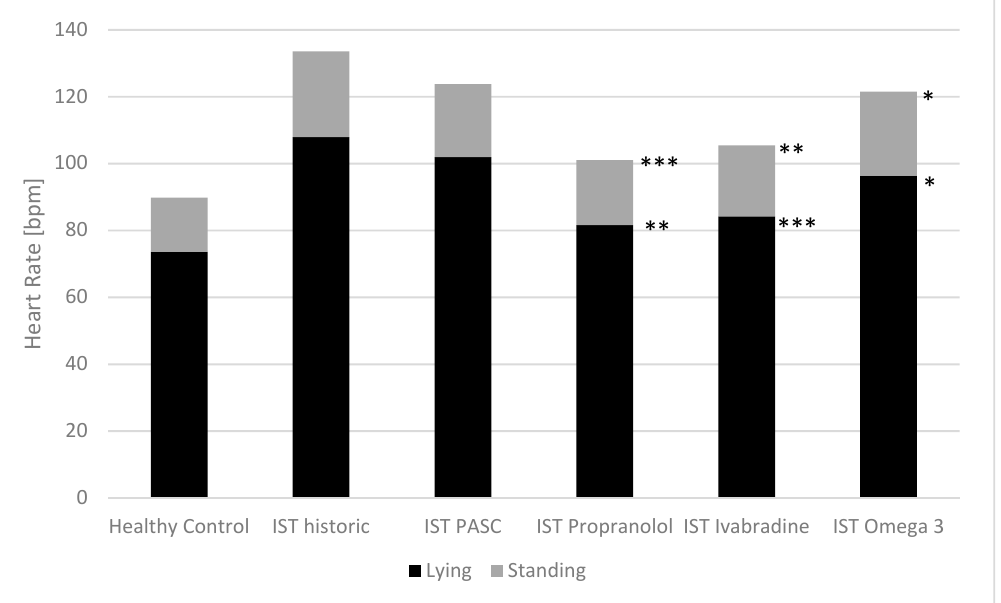
Figure 3. Baseline heart rates in the active standing test and the effect of treatment in children with inappropriate sinus tachycardia. PASC: Postacute sequalae of SARS-CoV-2 infection/vaccination; IST: inappropriate sinus tachycardia. Paired t-test between baseline and treatment: * p -value < 0.05; b ** p -value < 0.01; *** p -value < 0.001.